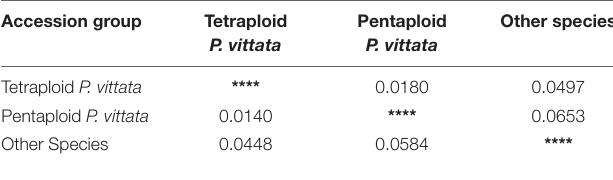
TABLE 7 | Nei’s Original measure of genetic distance (above diagonal) calculated according to [see Nei (1973) Am. Nat. 106:283–292] and Unbiased Measures of genetic distance (below diagonal) calculated according to [see Nei (1978) Genetics